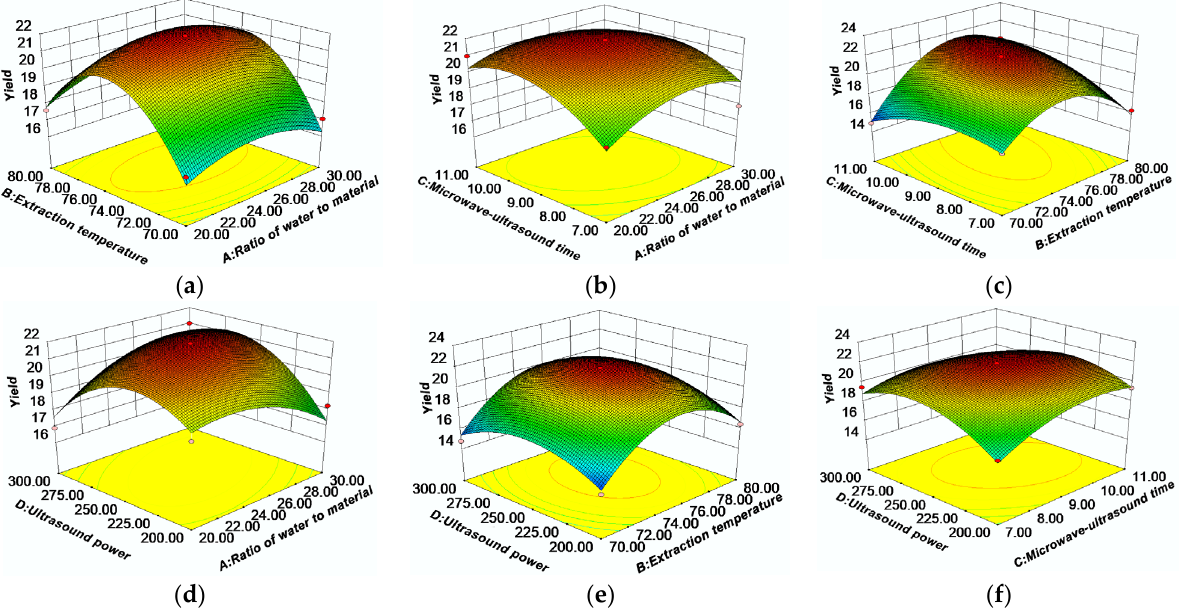
Figure 2. The response surface (3D) shows the effect of each variable ( a – f ) on the BRP